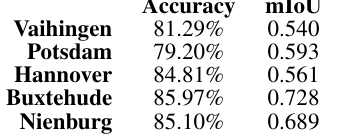
Table 2. Baseline performance of DeepLabv3+ using supervised training without any domain